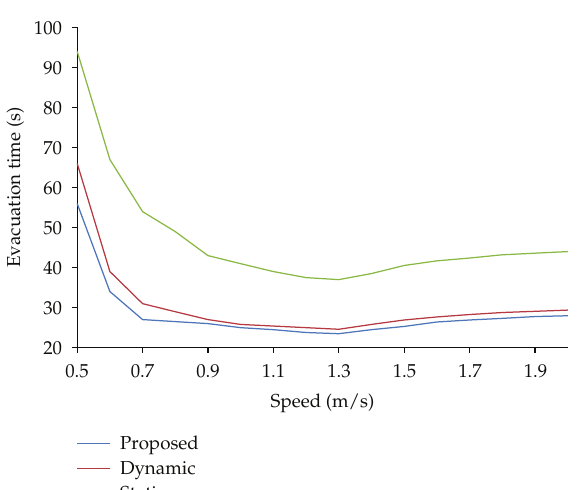
Figure 10: Relationship between the mean speed of occupants and evacuation time for the room in Figure 8.